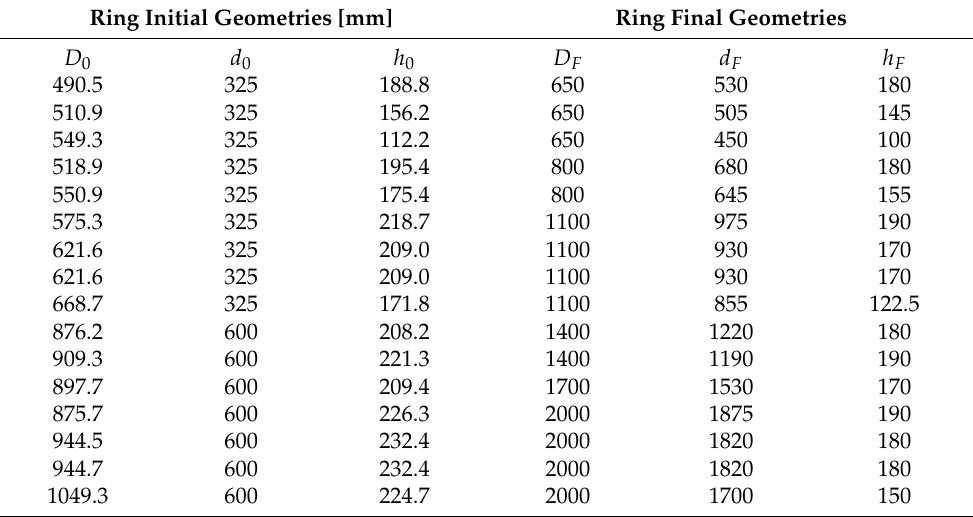
Table 2. Initial and final ring geometries.